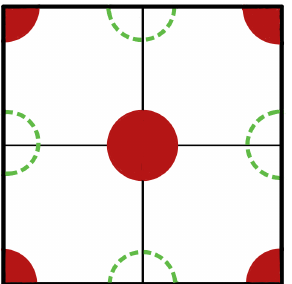
Figure 6: Calculation using the double cover of SO ( 4 ) . The figure depicts sad- ) plane. The center of the square is at ( 0,0 ) . The corners are at dles on ( ˜ ω , ˜ ω 1 2 ( 1,1 ) , ( 1, − 1 ) , ( − 1,1 ) , ( − 1,1 ) . For the bosonic case, all the saddles contribute. When we add fermions in the mix, the green coloured saddles at ( 0, ± 1 ) , ( ± 1,0 ) don’t con- tribute anymore, leading to an overall factor of 1 / 2. We have drawn circular re- gions arounds the saddle to denote how much the fluctuation around the saddle contributes. For example, each of the corner ones contributes one quarter of the center